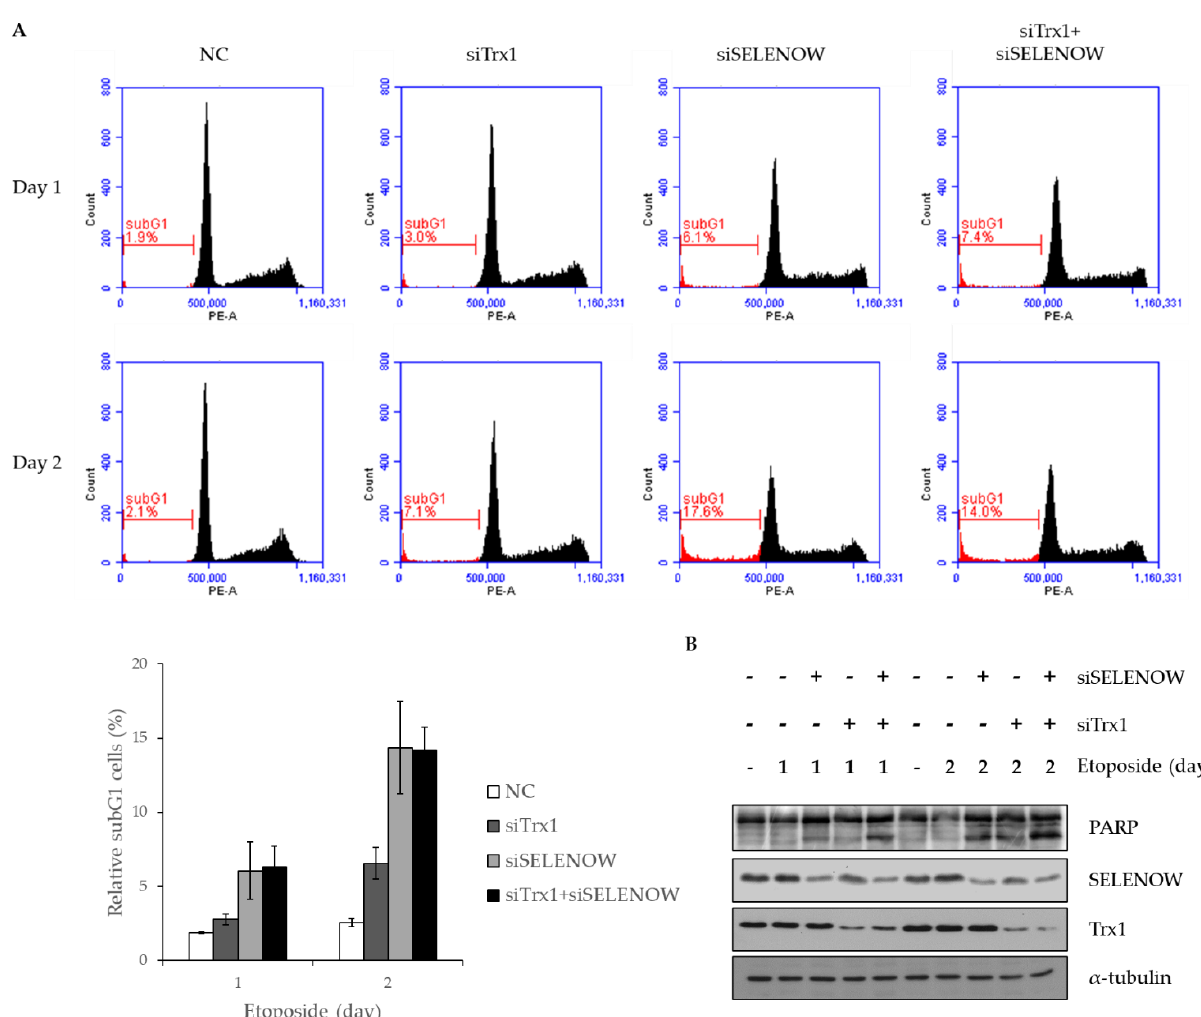
Figure 4. The cell death induced by DNA damage is regulated by the cooperation of SELENOW and Trx1. ( A ) Breast carcinoma MCF7 cells were transfected with siSELENOW or/and siTrx1 and incubated with etoposide (25 μM) for 24 or 48 h to induce DNA damage. Cells were harvested and subjected to FACS analysis (upper panel). The subG1 population is graphically represented (lower panel). The graph indicates the results from three independent experiments. The error bars in the graph indicate ±standard deviations (s.d.). ( B ) MCF7 cells were transiently transfected with siSELENOW or/and siTrx1. After 24 h, the cells were treated with etoposide (25 μM) for 24 or 48 h. The cells lysates were analyzed using Western blot assay using the indicated antibodies.